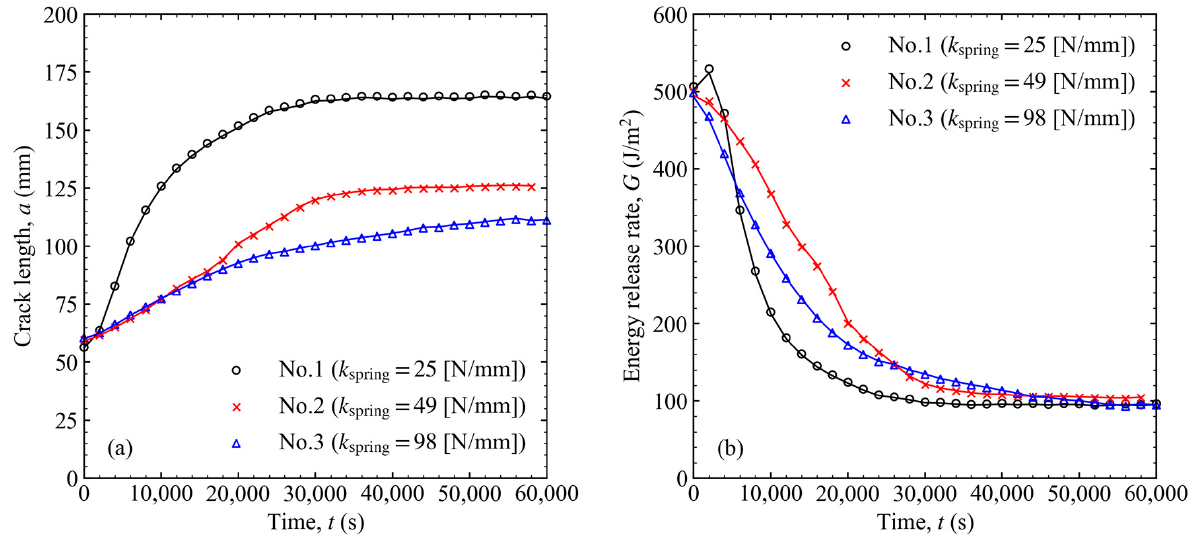
Figure 5. ( a ) Crack length and ( b ) energy release rate variation over time when the spring constant was changed to 25, 49, and 98 N/m.